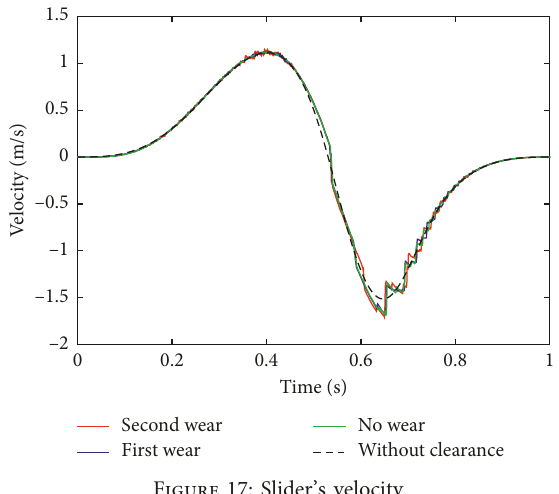
Figure 17: Slider’s